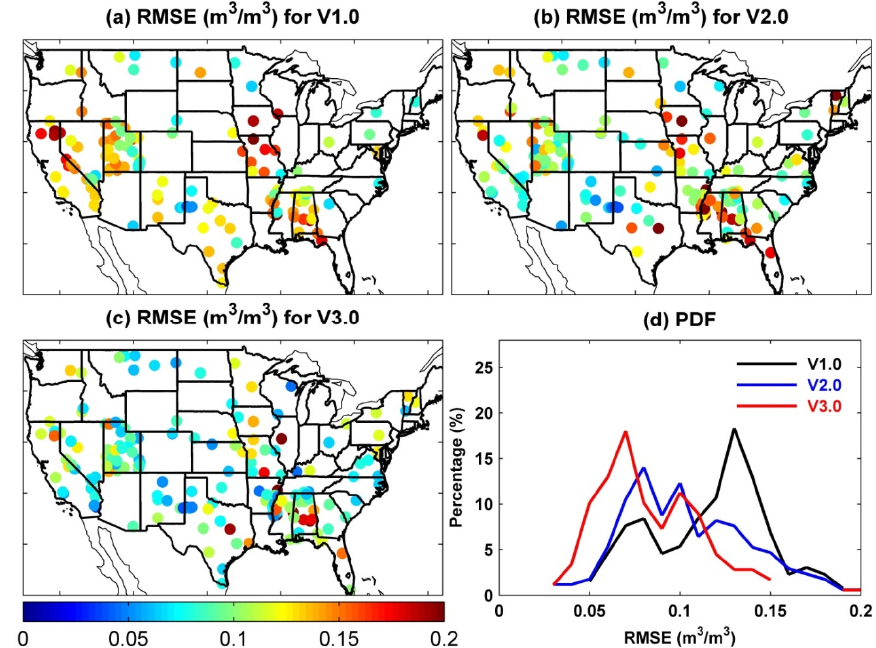
Figure 4. With respect to the quality controlled SCAN observations, root mean square errors (RMSEs in m 3 /m 3 unit) for ( a ) SMOPS version 1.0 over the 1 June 2007–3 November 2011 period, ( b ) SMOPS version 2.0 over the 16 November 2011–20 September 2016 period, ( c ) SMOPS version 3.0 over the 1 April 2015–31 December 2019 period, as well as ( d ) CONUS domain-averaged frequency probability as a function of RMSE for the three versions SMOPS blended soil moisture data products during the corresponding product time periods with curves shifting the toward left (right) indicating lower (greater) errors.